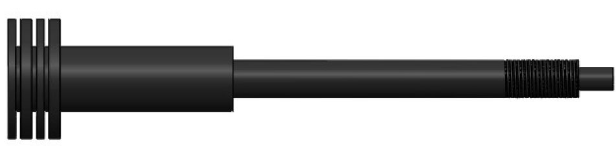
Figure 3. Turbocharger shaft